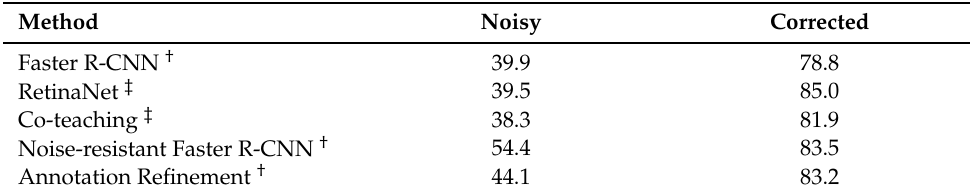
Table A1. Average precision scores (in percent) on the COWC dataset when training on different sets of labels. † , Faster R-CNN architecture; ‡ , RetinaNet architecture.